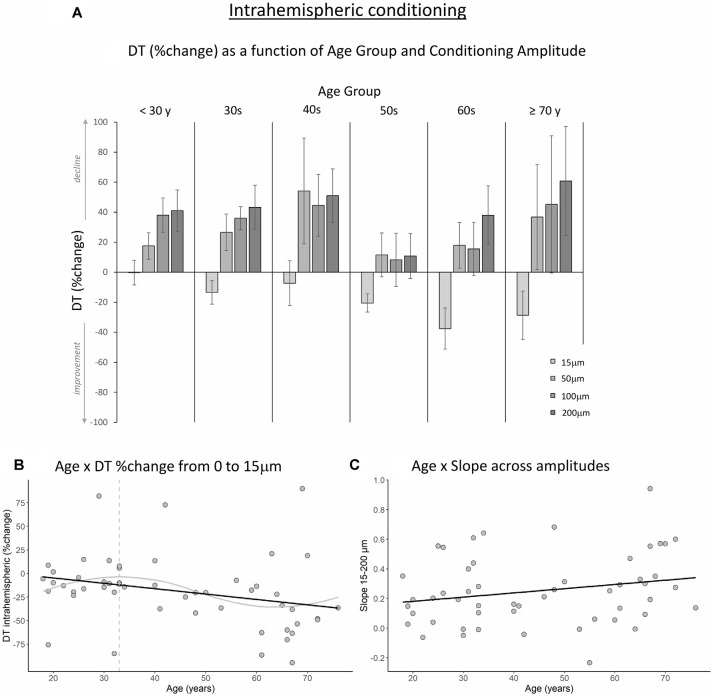
The effect of age on intrahemispheric conditioning. (A) DT (measured in %change compared to baseline) as a function of age group and amplitude of the conditioning stimulus. Data are plotted by age group for visualization purposes only; all analyses were conducted using age as a continuous variable. (B) The black line shows that with increasing age, DTs improved more when a conditioning stimulus (15 μm) was delivered to a neighboring finger (p = 0.016). The gray line shows the LOESS smoothed age trajectory; the dashed line indicates the age at which changes started. (C) The effect of increasing the conditioning stimulus amplitude on DT did not change significantly with age (p = 0.11).